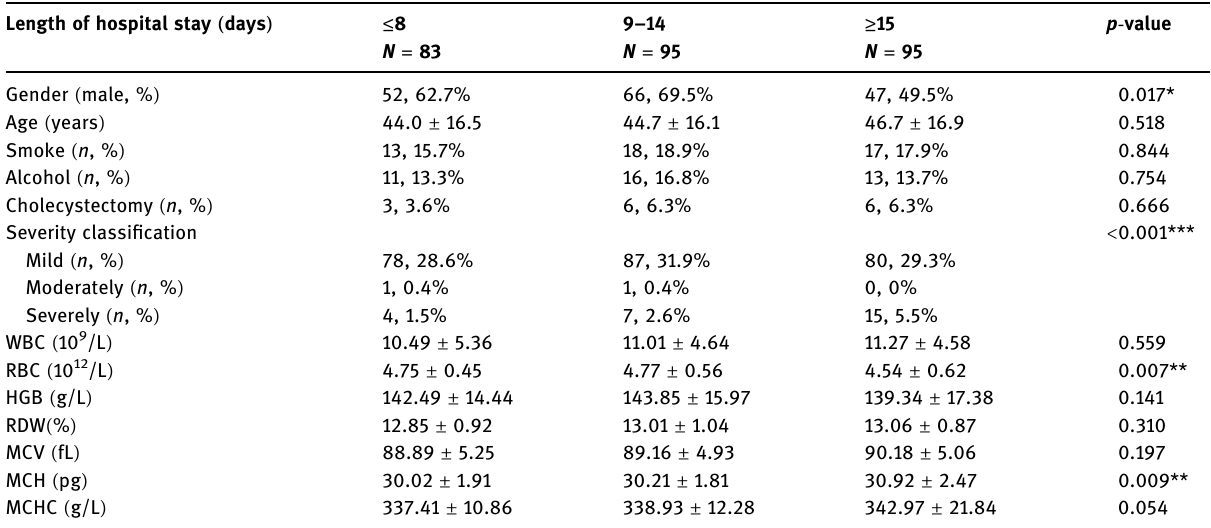
Table 1: The clinical and laboratory data according to length of hospital stay Length of hospital stay ( days )